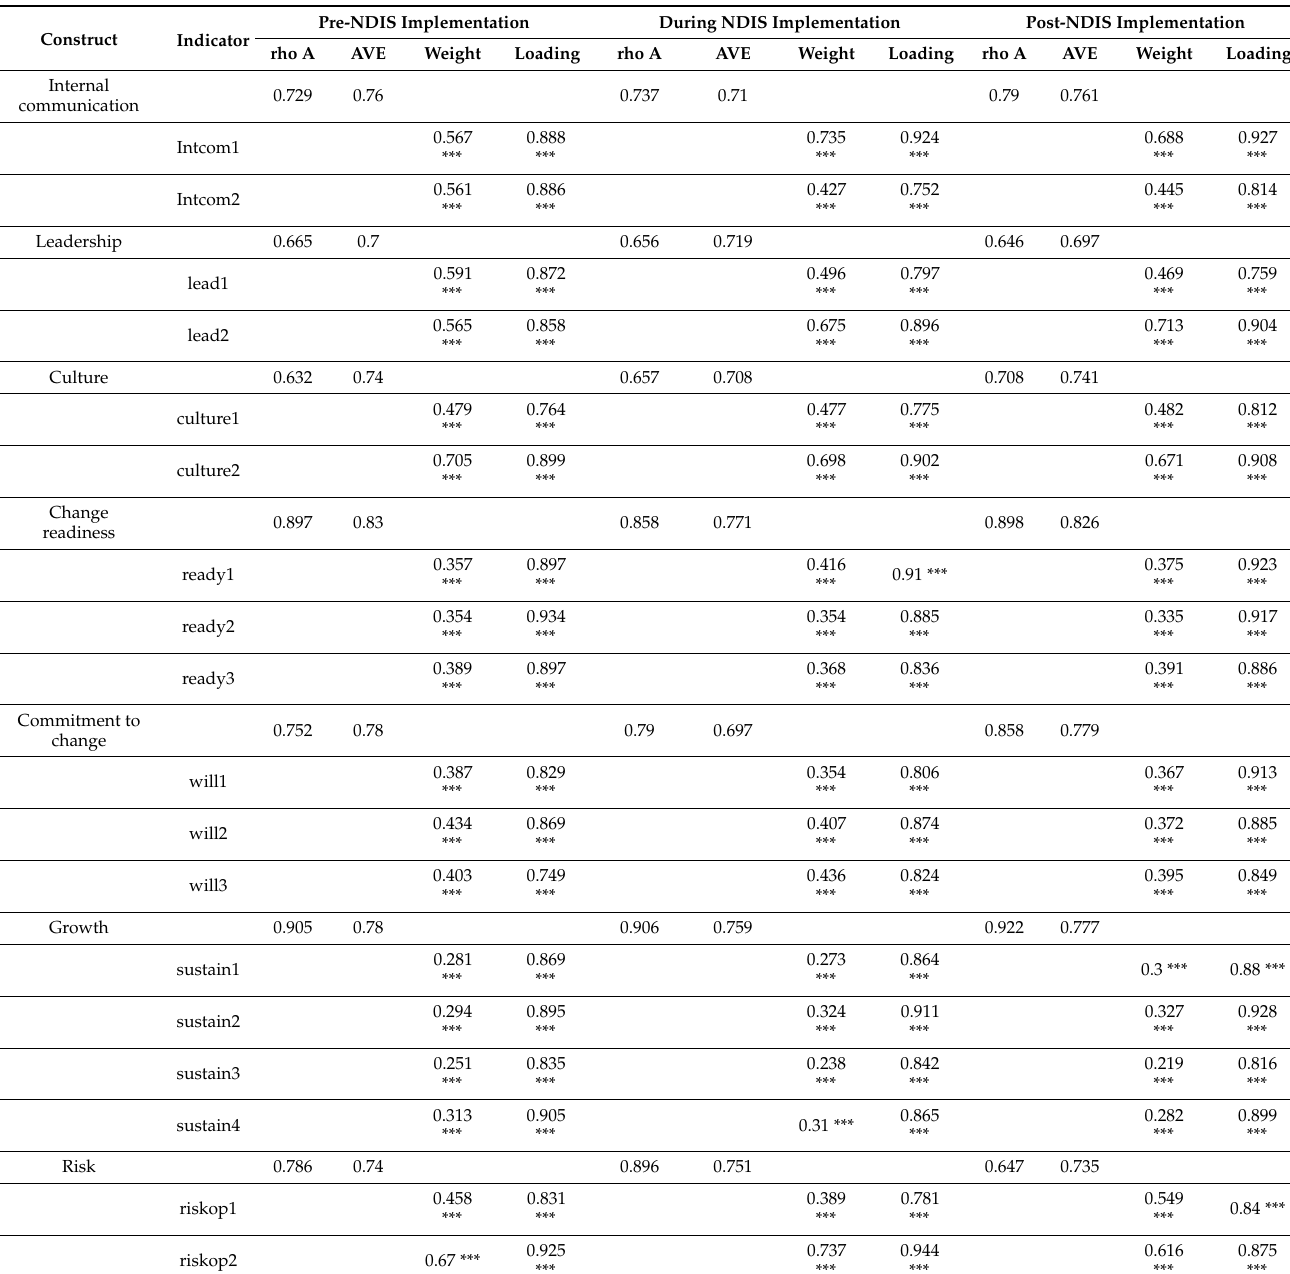
Table 3. Measurement model